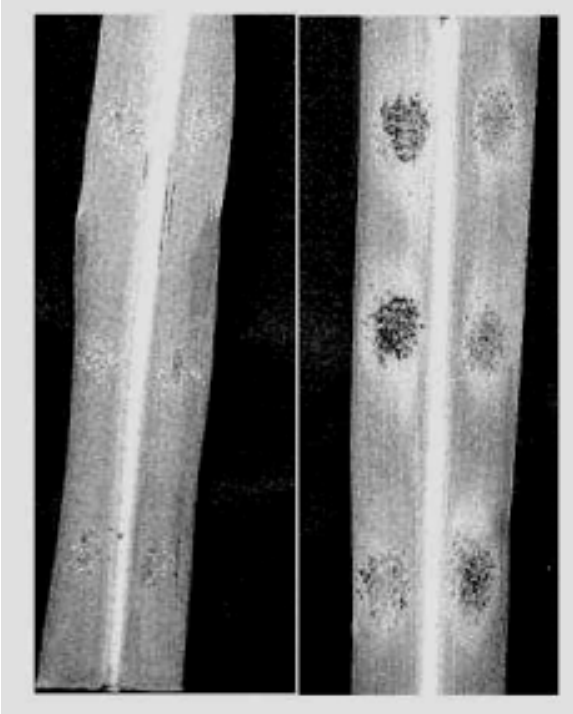
Fig 2. Phytotoxin-induced lesions on leaves of a suscep- tible sugarcane variety. Left, control; right, toxin treat- ment at 500 mg ml